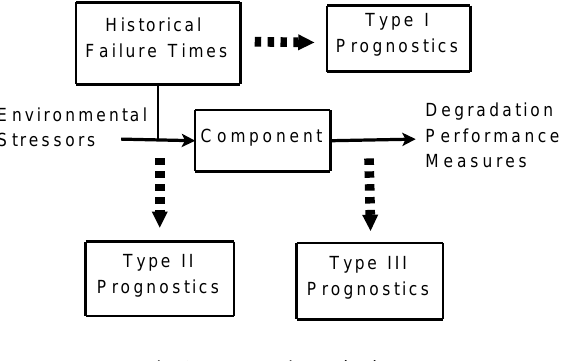
Fig. 2. Prognostic Method Types